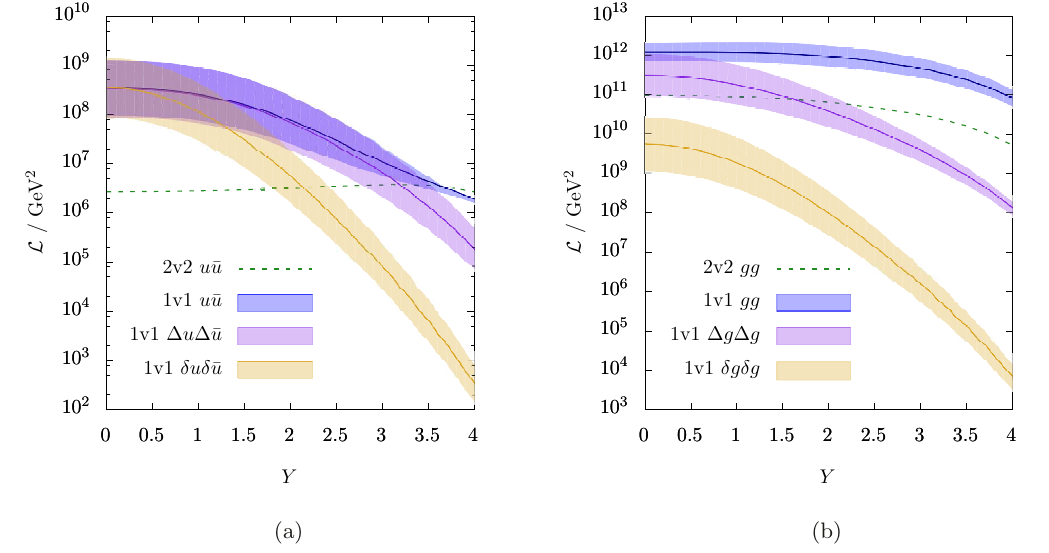
Figure 19 . As in figure 12, but with two polarised 1v1 luminosity bands included in each case (and the unpolarised 2v1 band